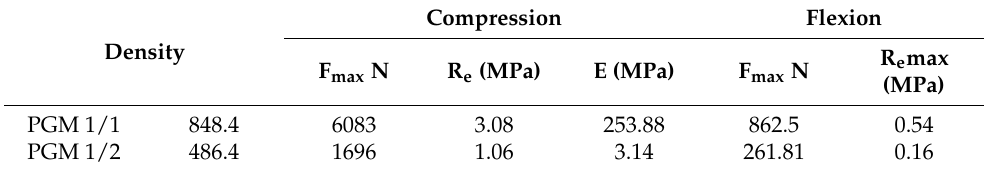
Table 7. Mechanical characteristics of the prepared